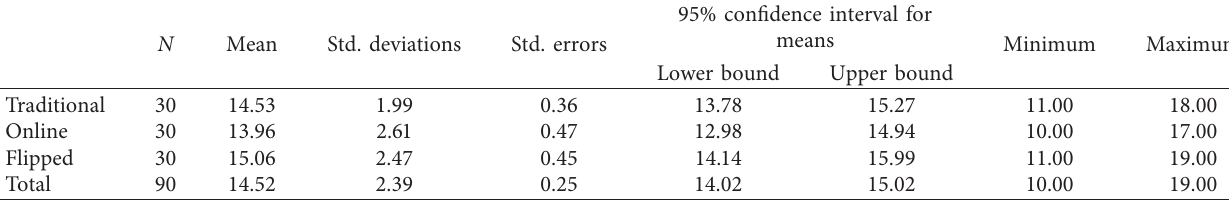
Table 1: Descriptive statistics of the groups in the vocabulary pretest.